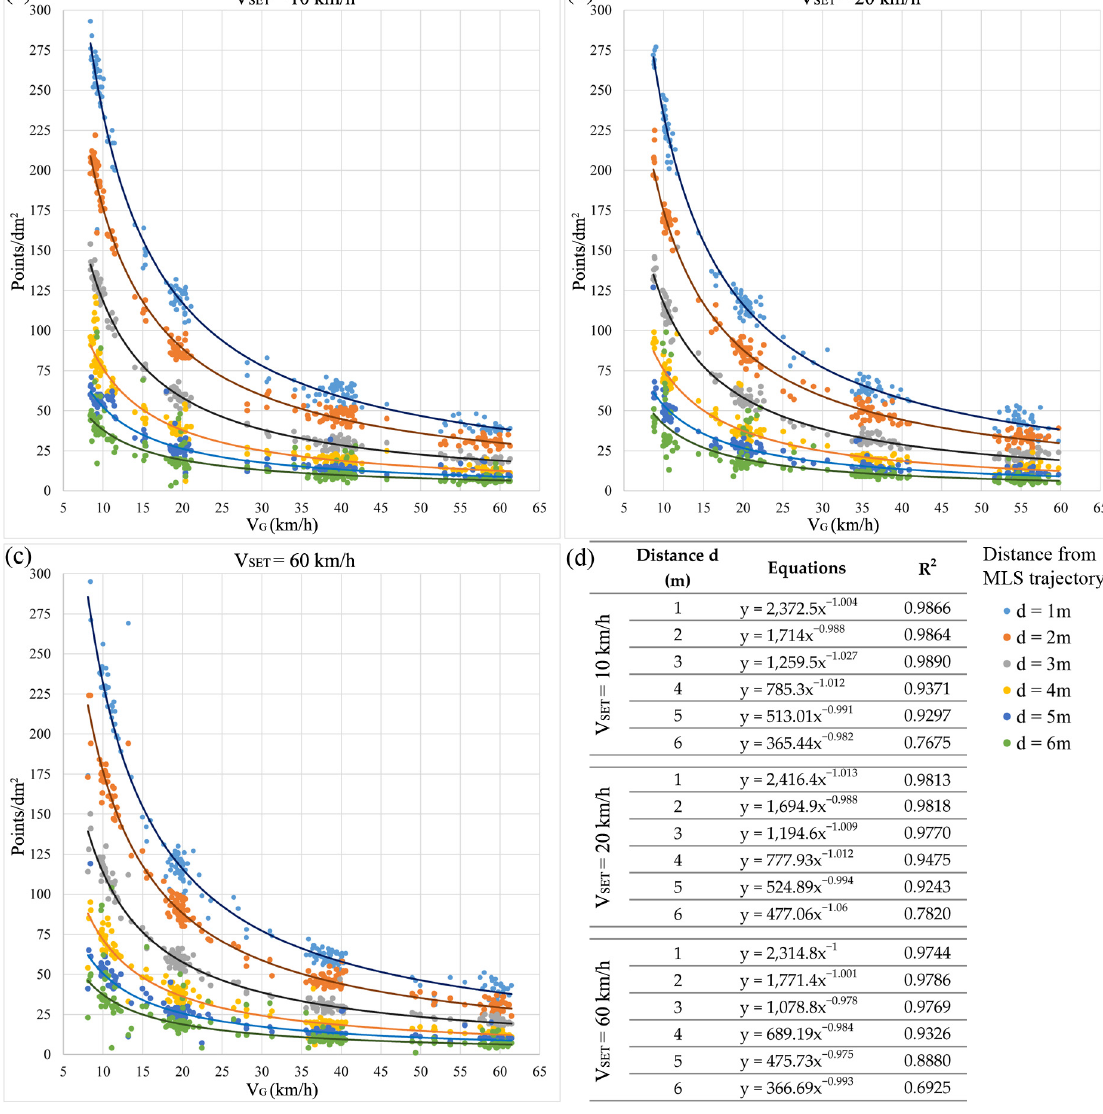
Figure 11. Correlation between point density and actual velocity for different distance from the tra- jectory for V SET setting of 10 km/h (panel a ), 20 km/h (panel b ) and 60 km/h (panel c ); ( d ) Equations of the best-fit curves and coefficients of determination.